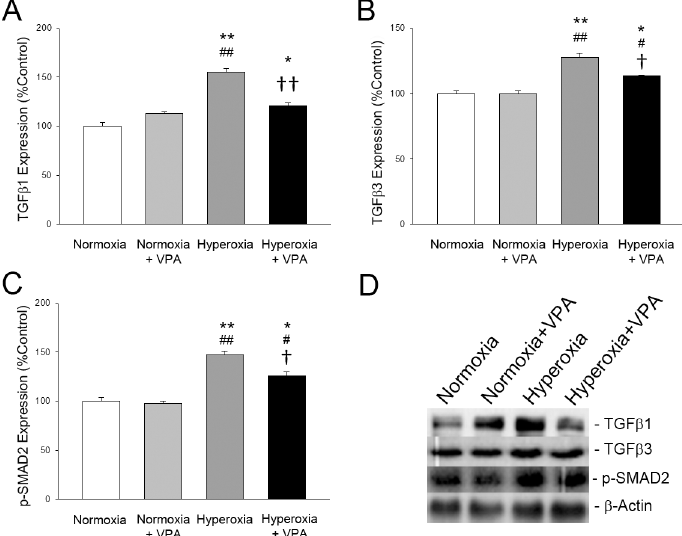
Fig 6. Bar graphs depicting TGF β 1 (A), TGF β 3 (B) and phospho-SMAD2 (C) expressions in lung tissues of rat pups. Panel D depicts representative bands for each protein, including β -Actin, the protein which was used as a loading control for western blotting. * p < 0.05 and ** p < 0.001 compared to Normoxia group; #p < 0.05 and ##p < 0.001 compared to Normoxia+VPA group; and † p < 0.05 and †† p < 0.001 compared to Hyperoxia group using One-Way ANOVA followed by post-hoc Tukey